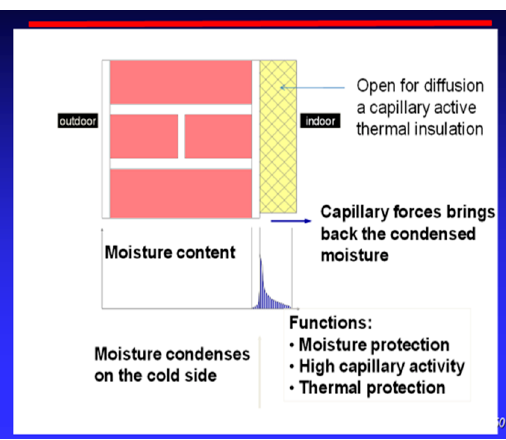
Figure 5. Explanation of the capillary active layer (CAL) Reprinted with permission of Peter Haeupl [25].